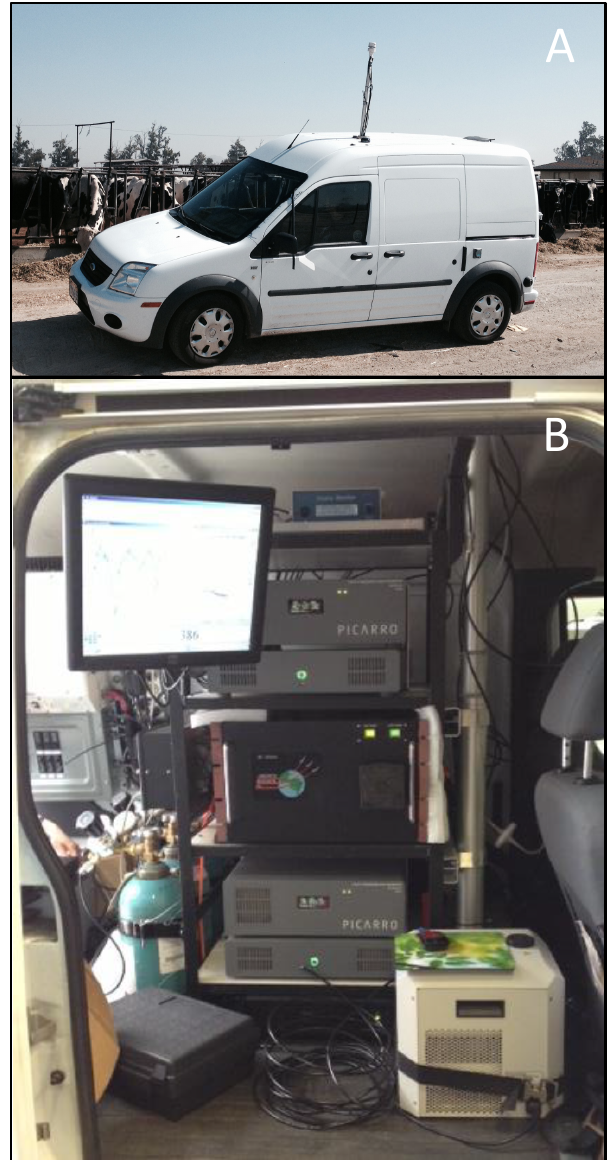
Figure 3. Images of the exterior (a) and interior (b) of the mobile observatory in